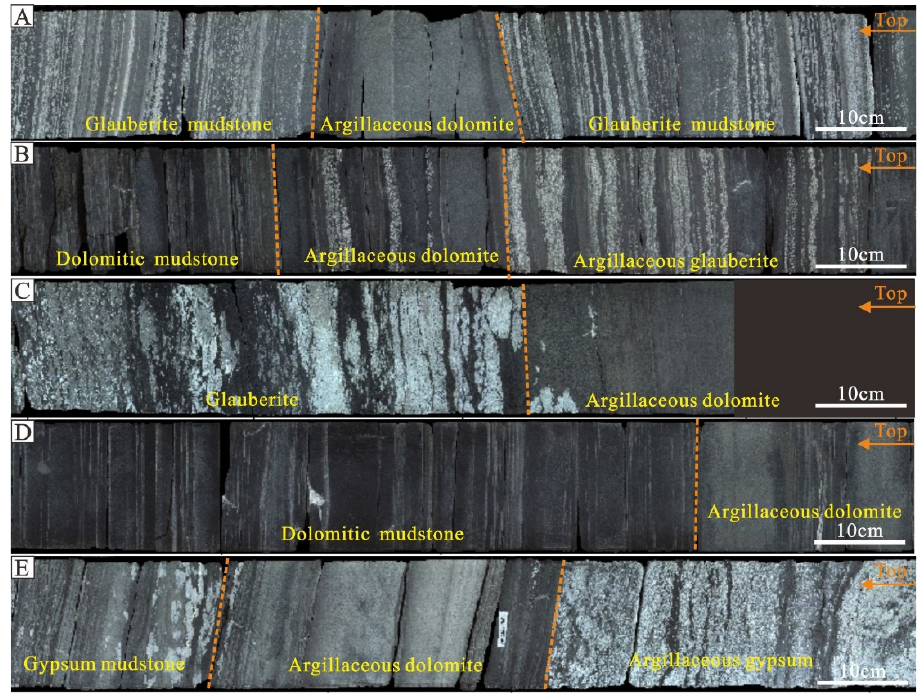
Figure 4. Lithofacies associations ( A ) LA1 well CY1 2754.6–2755.6 m ( B ) LA2 well CY1 2736.6–2737.6 m ( C ) LA3 well CY1 2708.5–2709 m ( D ) LA4 well CY1 2722–2732 m ( E ) LA5 well CY1 2648–2649